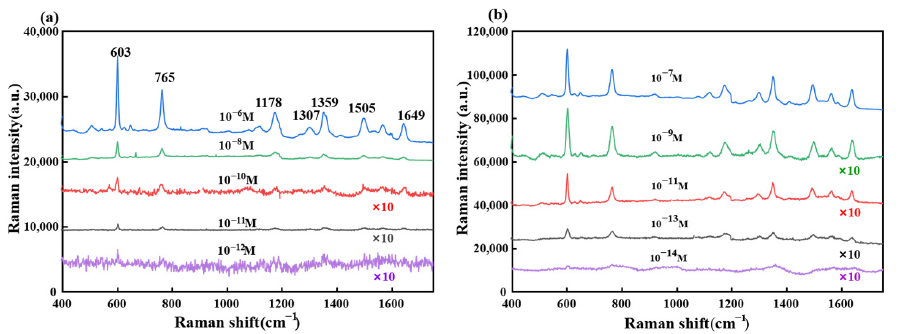
Figure 5. Raman spectra of ( a ) the composite Au–Ag nanostructures and ( b ) the composite Au–Ag nanostructures with the bottom Au mirror under different R6G molecule concentrations.